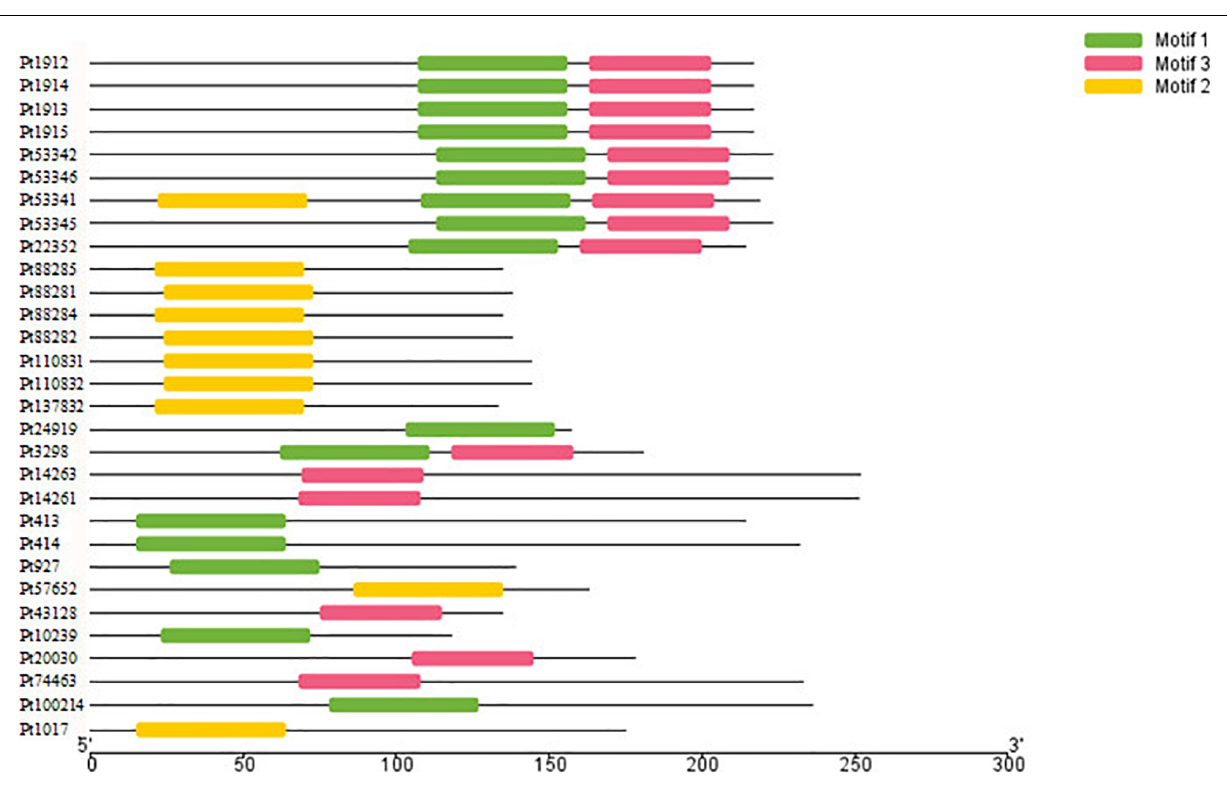
FIGURE 3 | The motifs location of secreted